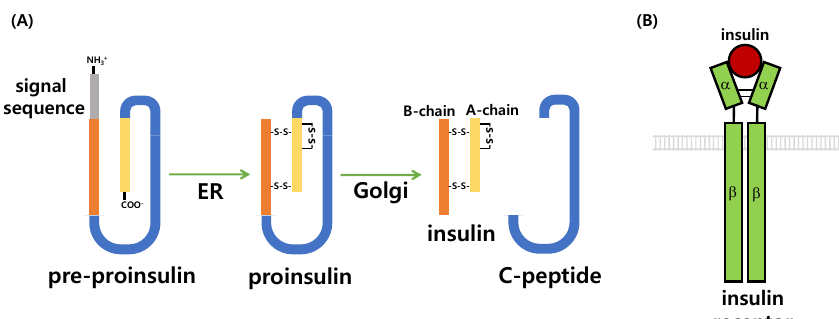
Figure 6. Insulin synthesis and insulin receptor. ( A ) Insulin biosynthesis begins as a precursor, preproinsulin, within the pancreatic β cell cytosol. Preproinsulin is comprised N-terminal signal sequence (gray), B-chain (orange), C-peptide (blue), and A-chain (yellow). Preproinsulin translocates into the endoplasmic reticulum and by cleavage of the signal sequence, forms proinsulin. The proinsulin folds by forming 3 disulfide bonds then trafficking through Golgi complex into secretory granules. Prohormone convertase and carboxypeptidase E processes proinsulin to C-peptide and mature insulin composed with A- and B-chain. ER: endoplasmic reticulum. ( B ) Insulin receptor is a dimer of identical units that span the cell membrane. Each of the 2 subunits is made of α-chain and β-chain, connected by a single disulfide bond. The α-chain is located extracellular and binds with insulin. The β-chain spans the cell membrane and has a tyrosine kinase domain which is activated when insulin binds to the α-chain.